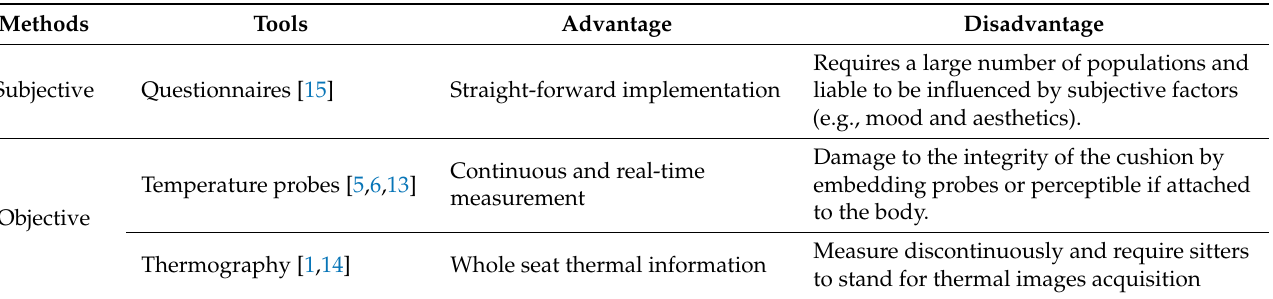
Table 1. Comparison of methods measuring the body-seat interface thermal